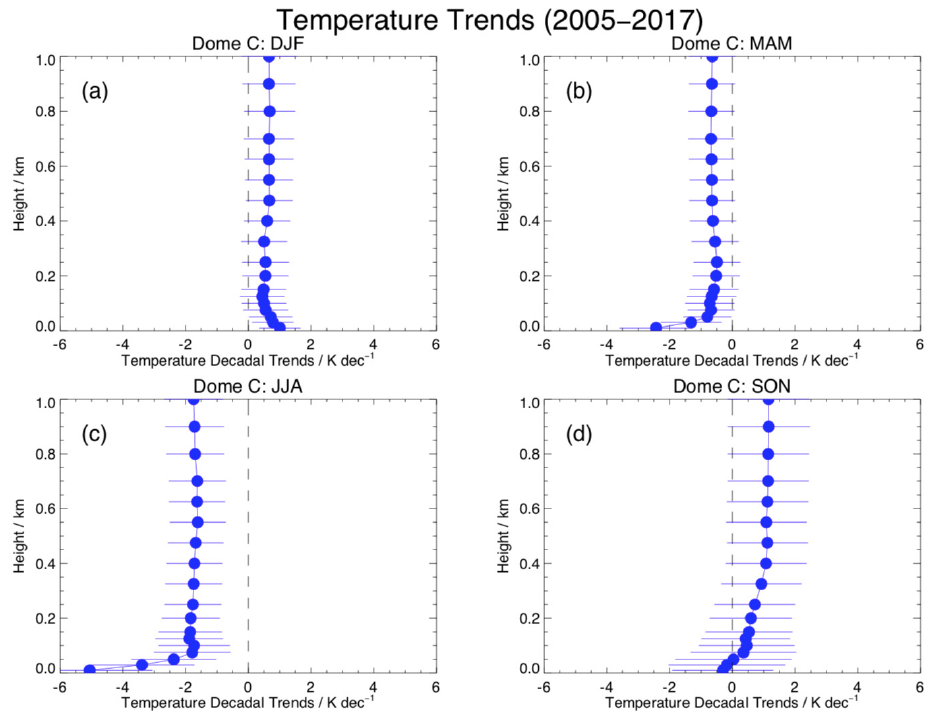
Figure 8. Mean profile of the decadal linear trends in temperature at Dome C from radiosondes over the period 2005–2017 in: ( a ) DJF; ( b ) MAM; ( c ) JJA; and ( d ) SON. Horizontal bars represent 1- σ error.